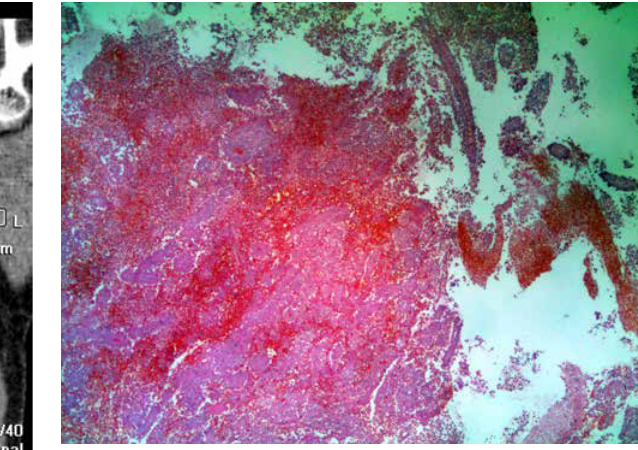
Figure 2: The H/E staining of the tumor tissue